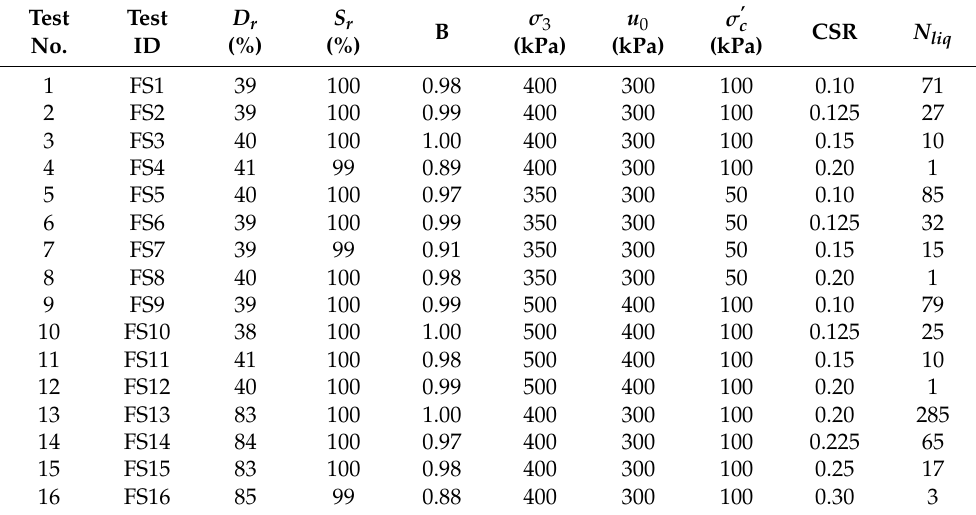
Table 2. Test parameters and typical results for nearly or fully saturated sand specimens.